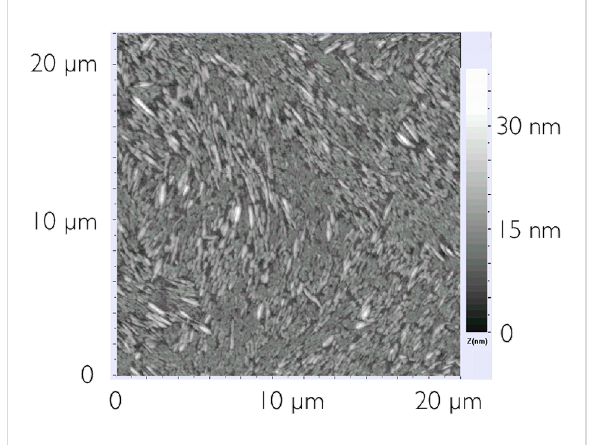
Figure 5: Small, elongated aggregates form a nematic-like texture, possibly due to the formation of a lyonematic phase during solvent evaporation.